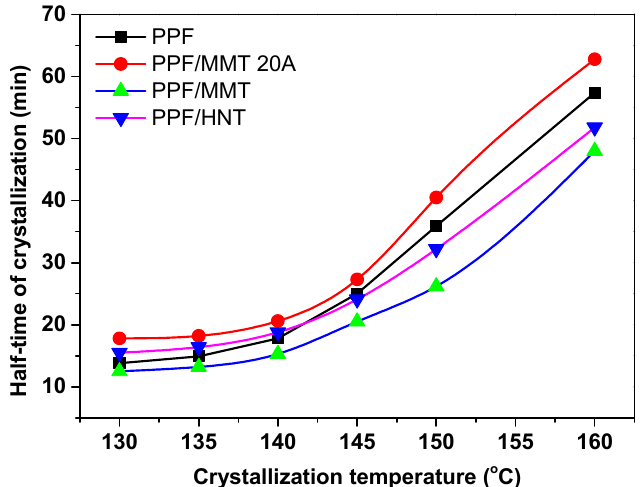
Figure 6. Dependence of the half-time of crystallization to isothermal crystallization temperature, for neat PPF and the nanocomposites.